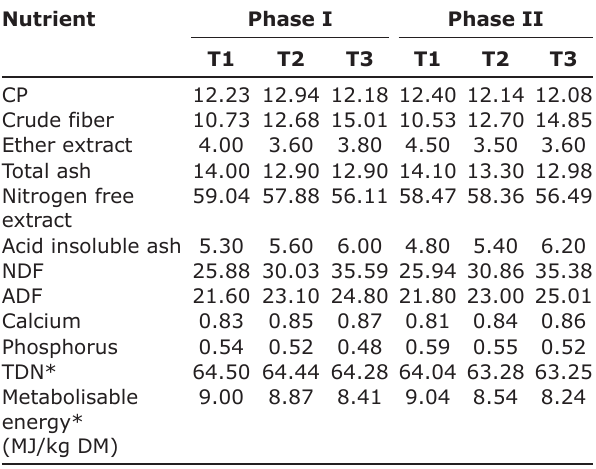
Table-2: Chemical composition of complete offered to cows in Phases I and II (% DM basis).